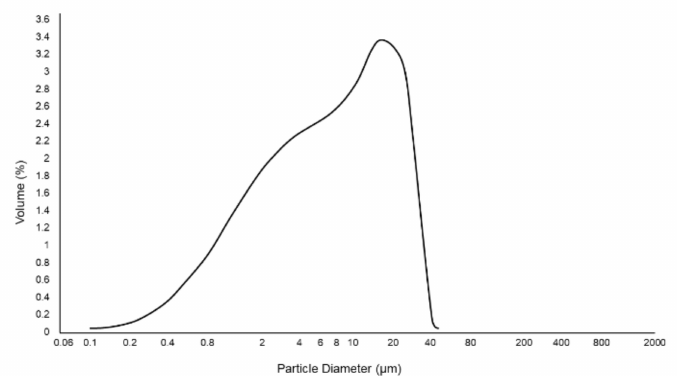
Figure 1. Particle size distribution of 47.5B glass powder (sieved below 32 µ m) used for sca ff old